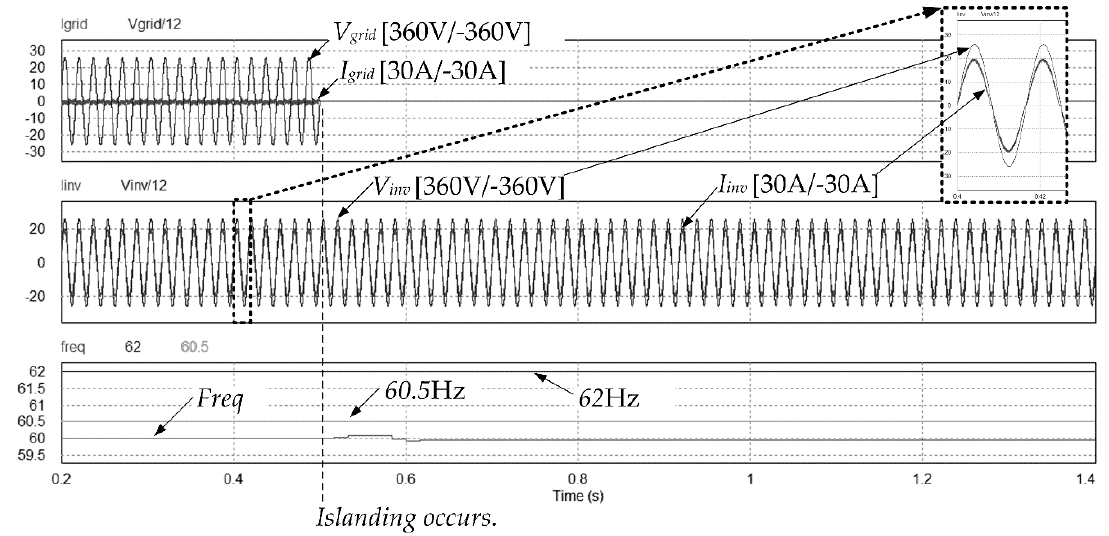
Figure 8. Anti-islanding test results when active frequency drift method ( cf = 5%) is used.